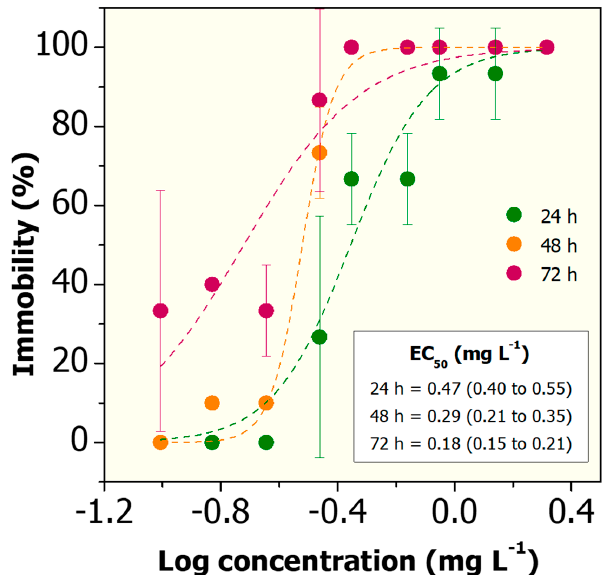
Figure 6. Acute toxicity of Cd 2+ following co-exposure with BSA at 5.0 mg L − 1 to D. magna after 24, 48 and 72 h in reconstituted water. PriProbit software was used to obtain the EC 50 values via Probit analysis including 95% confidence limits.